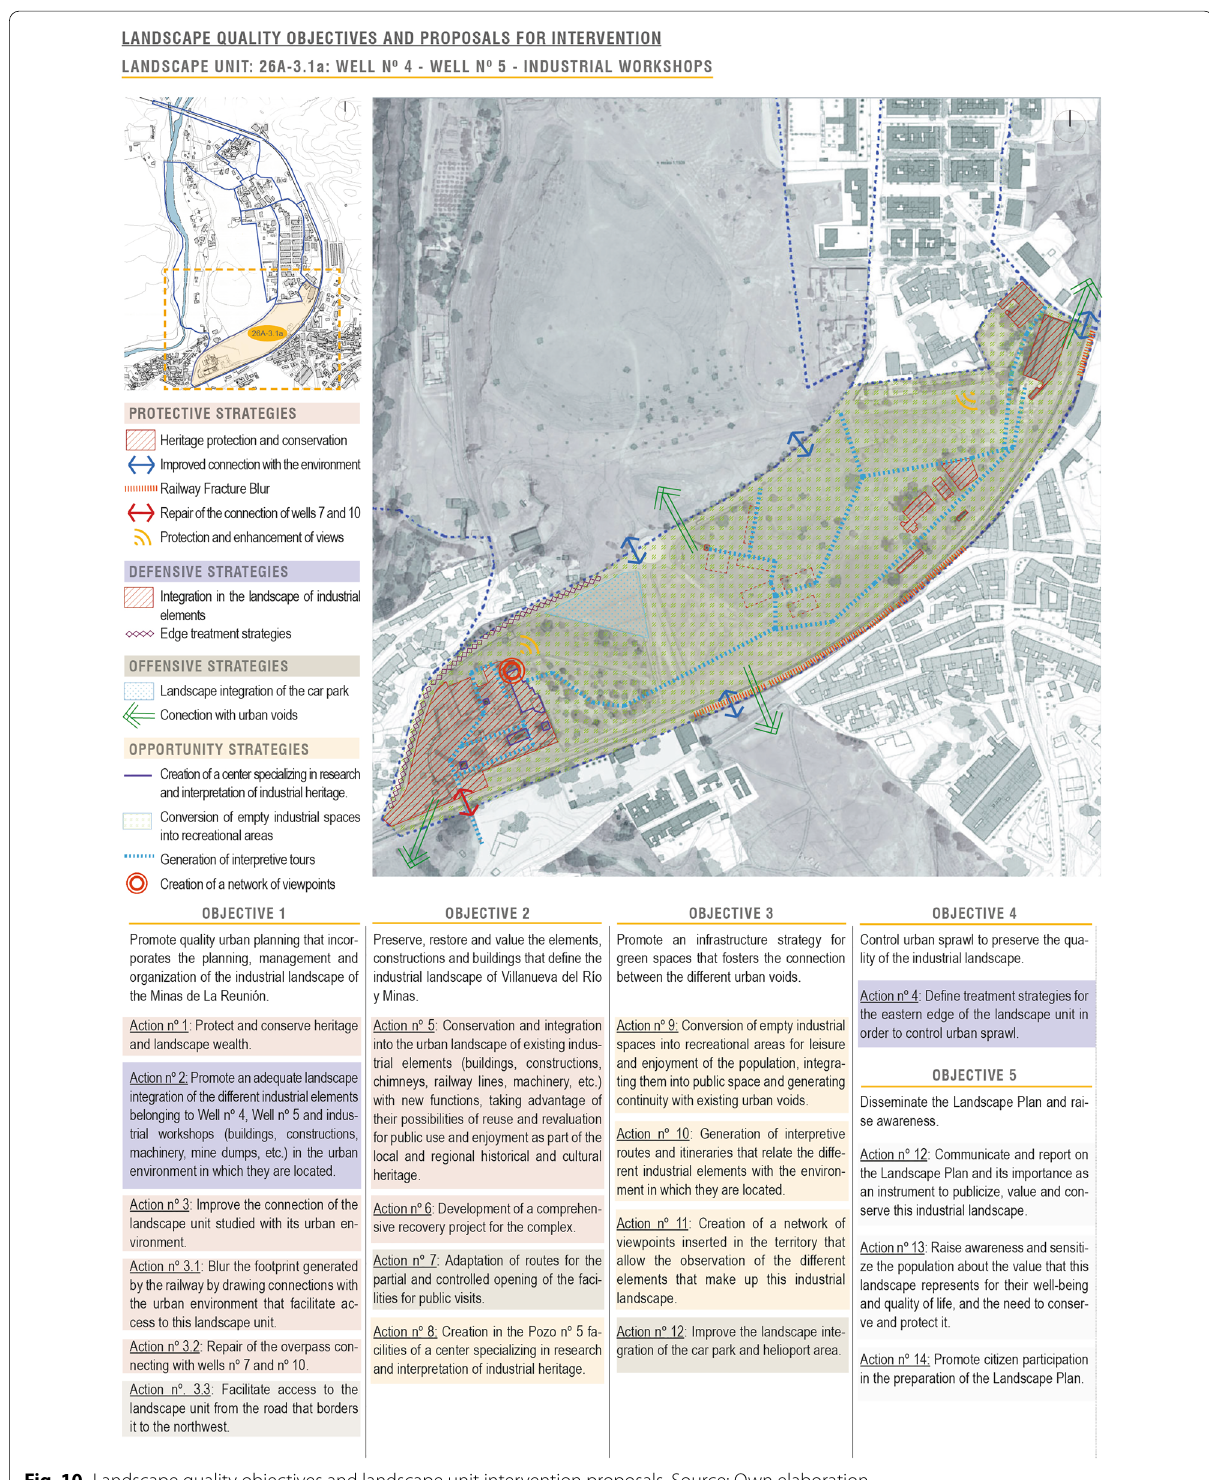
Fig. 10 Landscape quality objectives and landscape unit intervention proposals. Source: Own